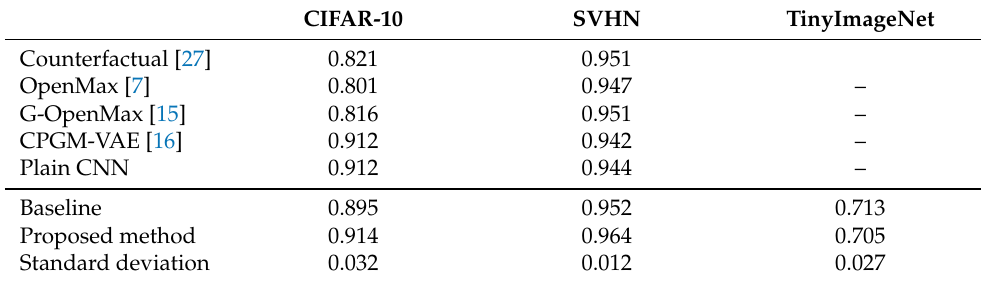
Table 3. Closed-set accuracy across six known